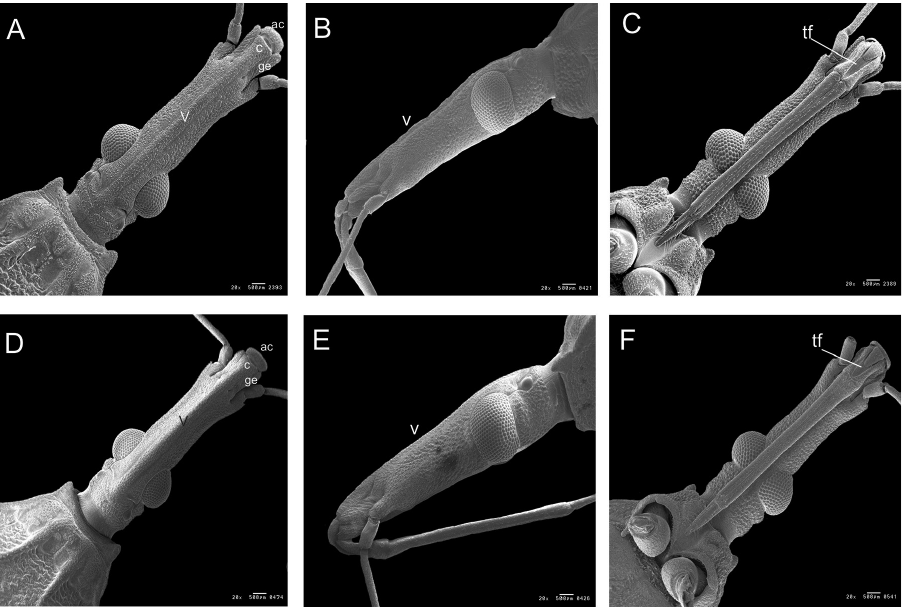
Figure 3. Head by SEM of R. taquarussuensis sp. n. A dorsal view B lateral view, C ventral view, R. neglectus D dorsal view E lateral view F ventral view. v: vertice, ge: gena, c: clypeus, ac: anteclypeus, tf: triangular furrow.